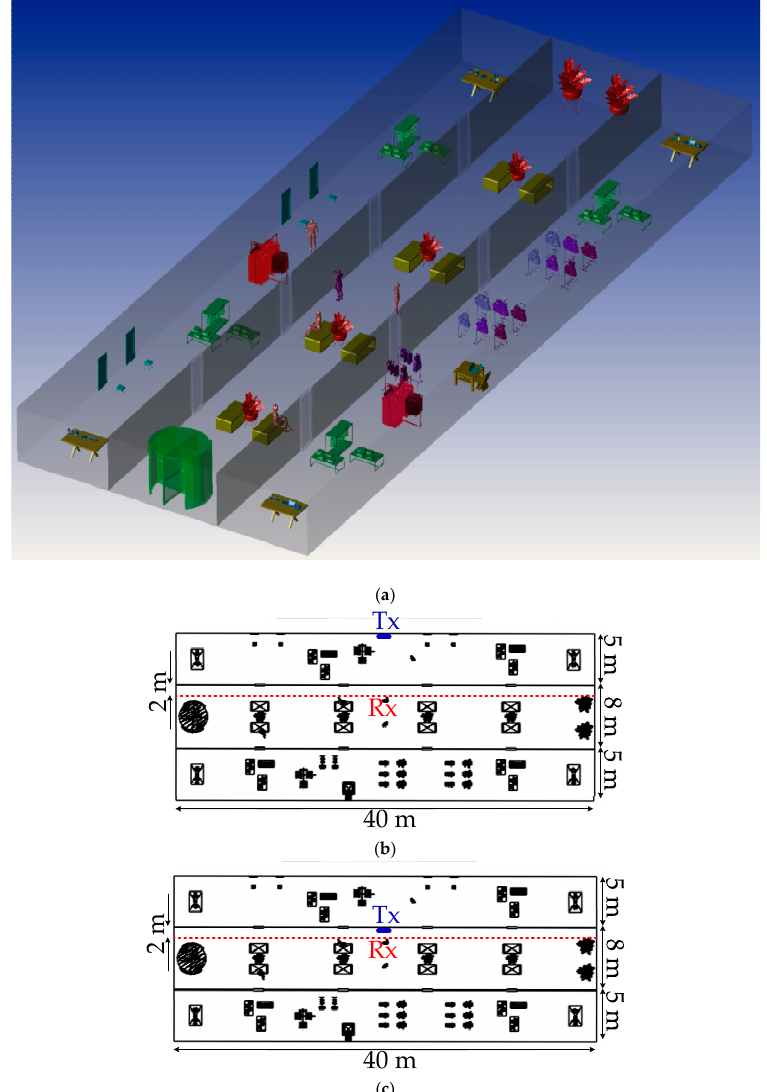
Figure 4. ( a ) The three-dimensional corridor environment and proposed scenarios which show the location of Rx and Tx, ( b ) case1 where Tx is located on inner shop wall behind window, and ( c ) case2 on wall or shop window inside the corridor.